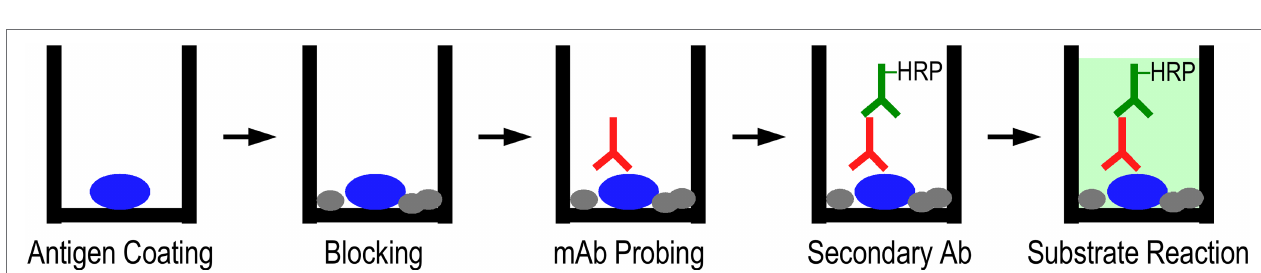
FIGURE 2 | ELISA-based mAb epitope analysis. Protein of interest was coated on a microtiter plate in a buffer containing the desired additives, which can be used as the buffer throughout the entire assay or modified in later steps. After blocking the plate, the mAb conformational probe was incubated in serial dilutions, followed by washes and incubation with horse radish peroxidase (HRP)-conjugated secondary antibody. After final washes, the binding of mAb probes was detected via H 2 O 2 -ABTS colorimetric substrate reaction and recording the development of absorbance at 420